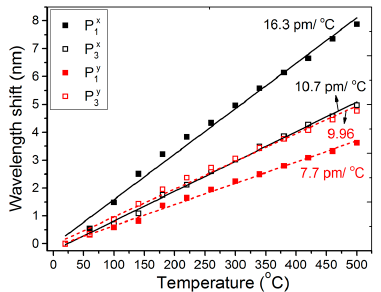
Figure 7. Temperature response of the fiber m-MZI using highly birefringent ATC-PCF ( L ~ 5.1 cm).